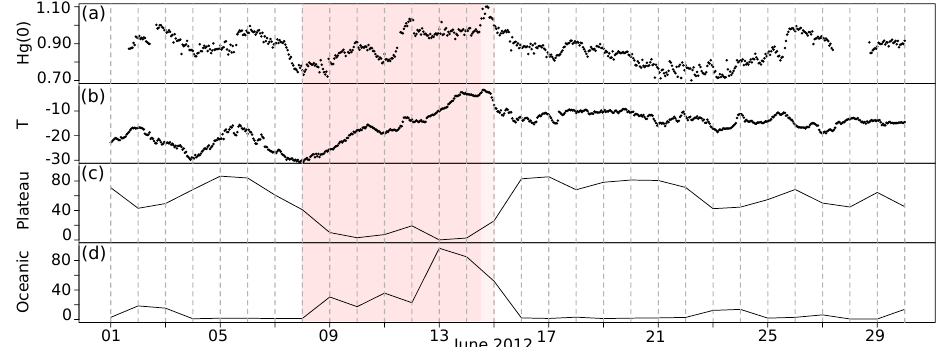
Figure 5. June 2012 variation of (a) Hg(0) concentration (ngm − 3 ), (b) temperature ( ◦ C), (c) daily averaged percentage (%) of air masses originating from the Plateau (HYSPLIT model simulations), and (d) daily averaged percentage (%) of air masses originating from the ocean (HYSPLIT model simulations). From 8 to 14 June (period highlighted in red), both Hg(0) and temperature increased suggesting an advection of air masses from mid-latitudes, as confirmed by an elevated percentage of oceanic air